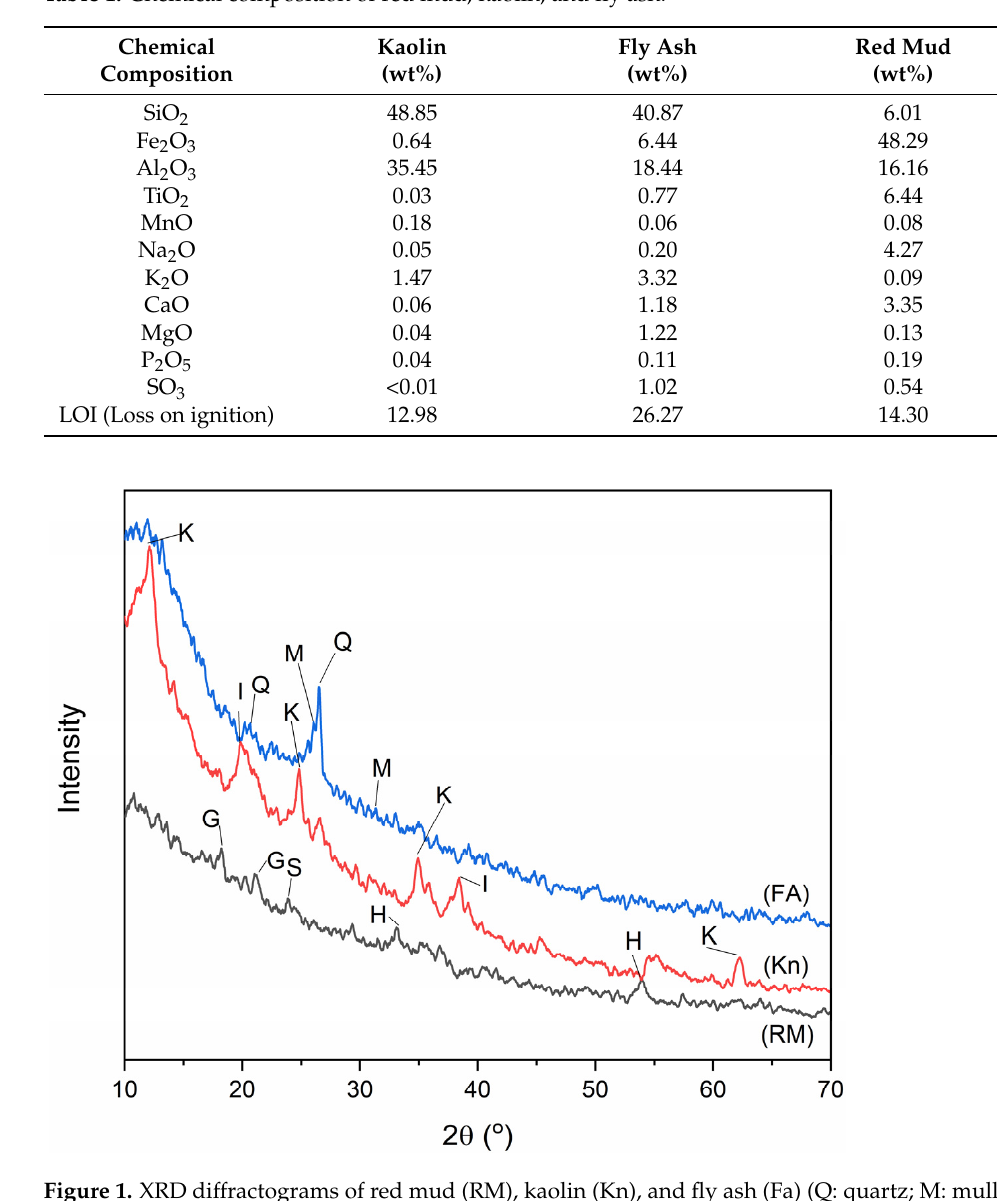
Table 1. Chemical composition of red mud, kaolin, and fly ash.